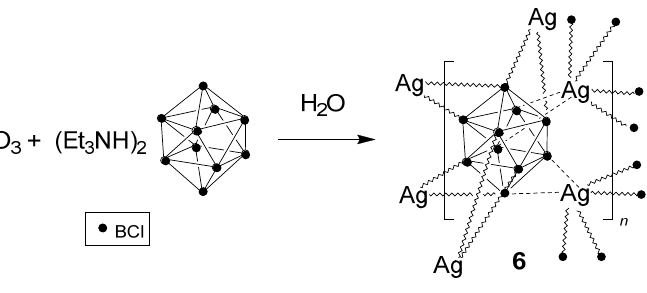
Table 3. Selected parameters (Å ) of silver(I) coordination polyhedra in complexes with some chlorinated boron cages.